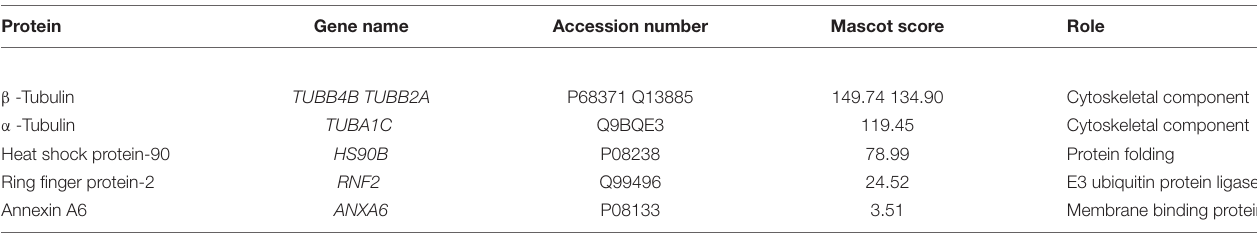
TABLE 1 | Trafficking proteins identified by LC–MS/MS